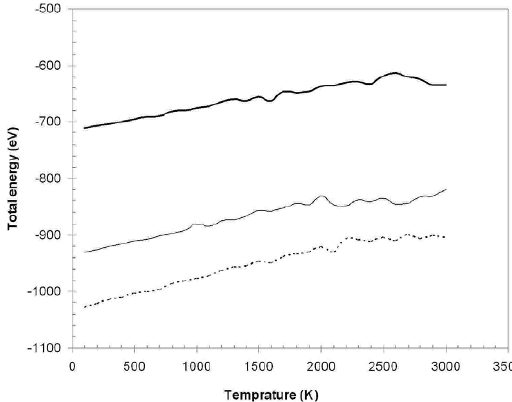
Figure 6. Total energy versus temperature of some of the diamond D substructures: (20 5 _20 2 _85)H 5 line); (20 6 _28 2 _110)H (line) and (28 5 _20 2 _120)H 68 (dotted